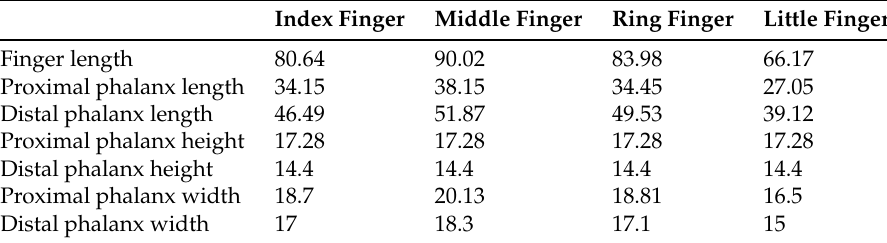
Table 1. Dimensions in [mm] of the finger